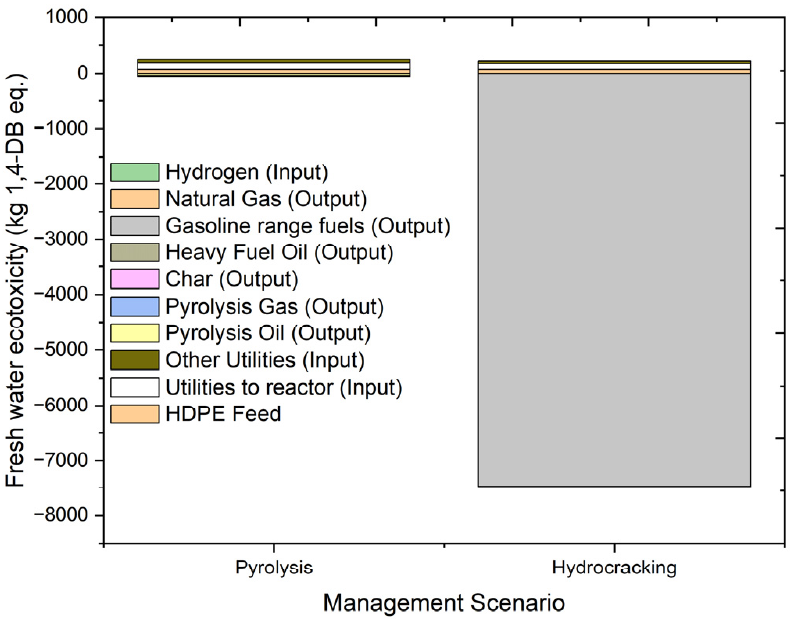
Figure 12. Impact assessment of pyrolysis and hydrocracking for the management of waste HDPE on fresh water ecotoxicity (kg 1,4-DB